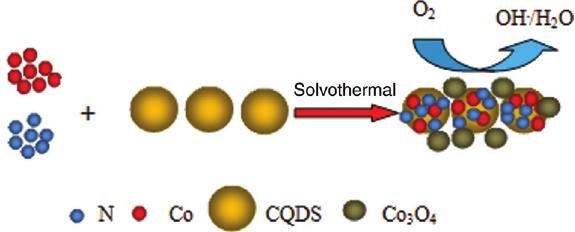
Figure 1: Schematic illustration of the preparation of Co/N/C cata- lysts and their catalytic ability for oxygen reduction reaction